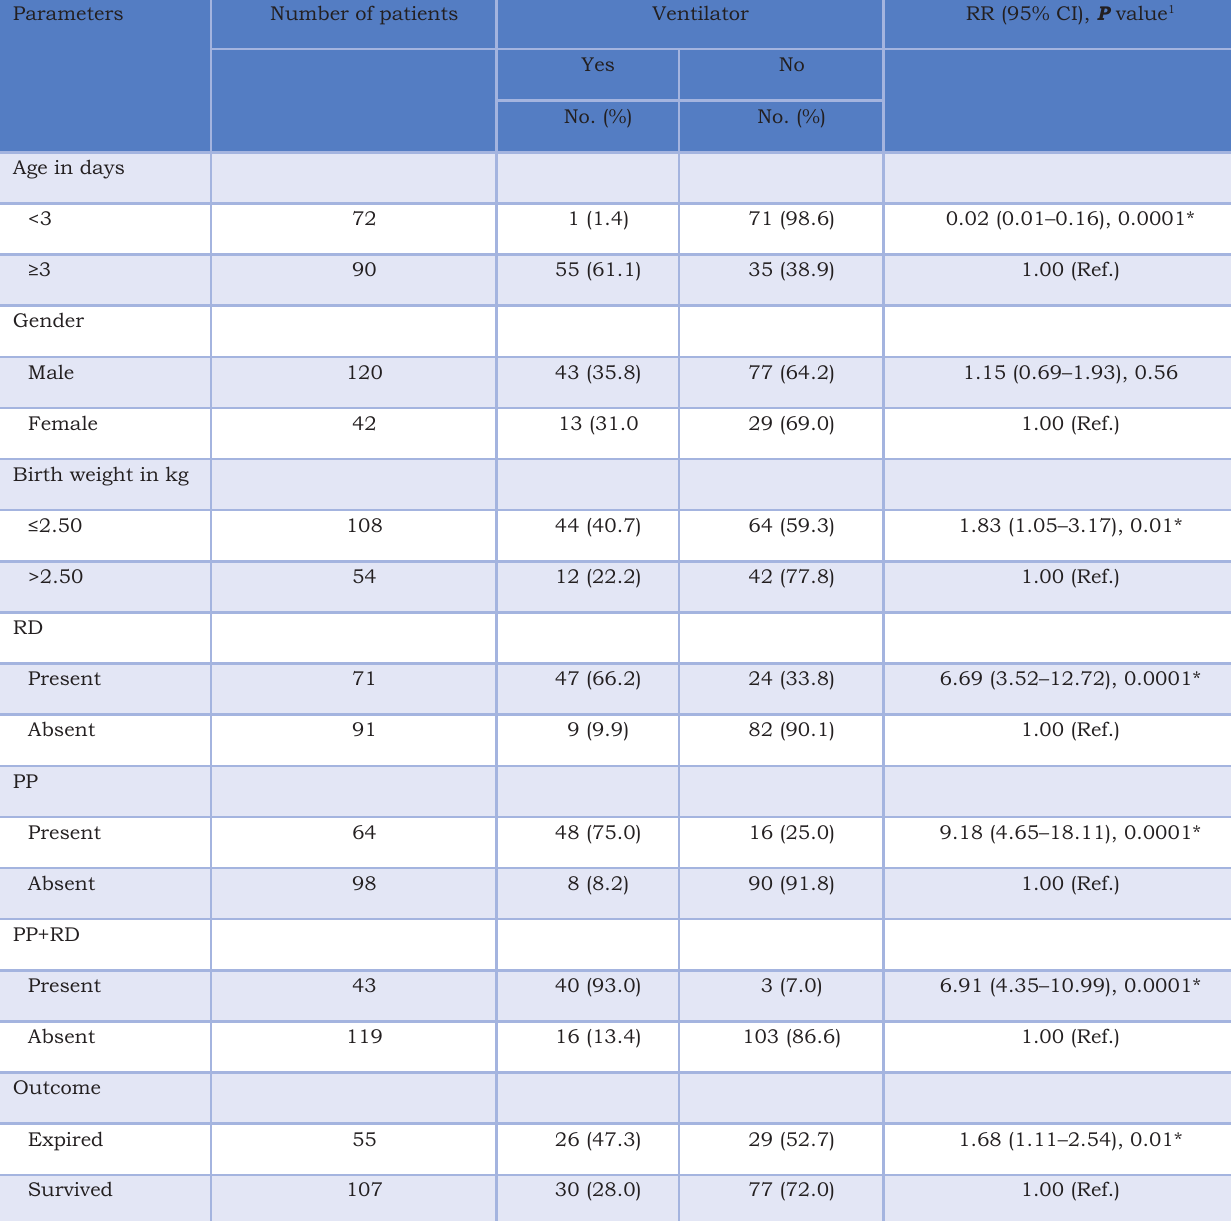
Table 2: Association of clinical and radiological factors with ventilator requirement in post-operative period